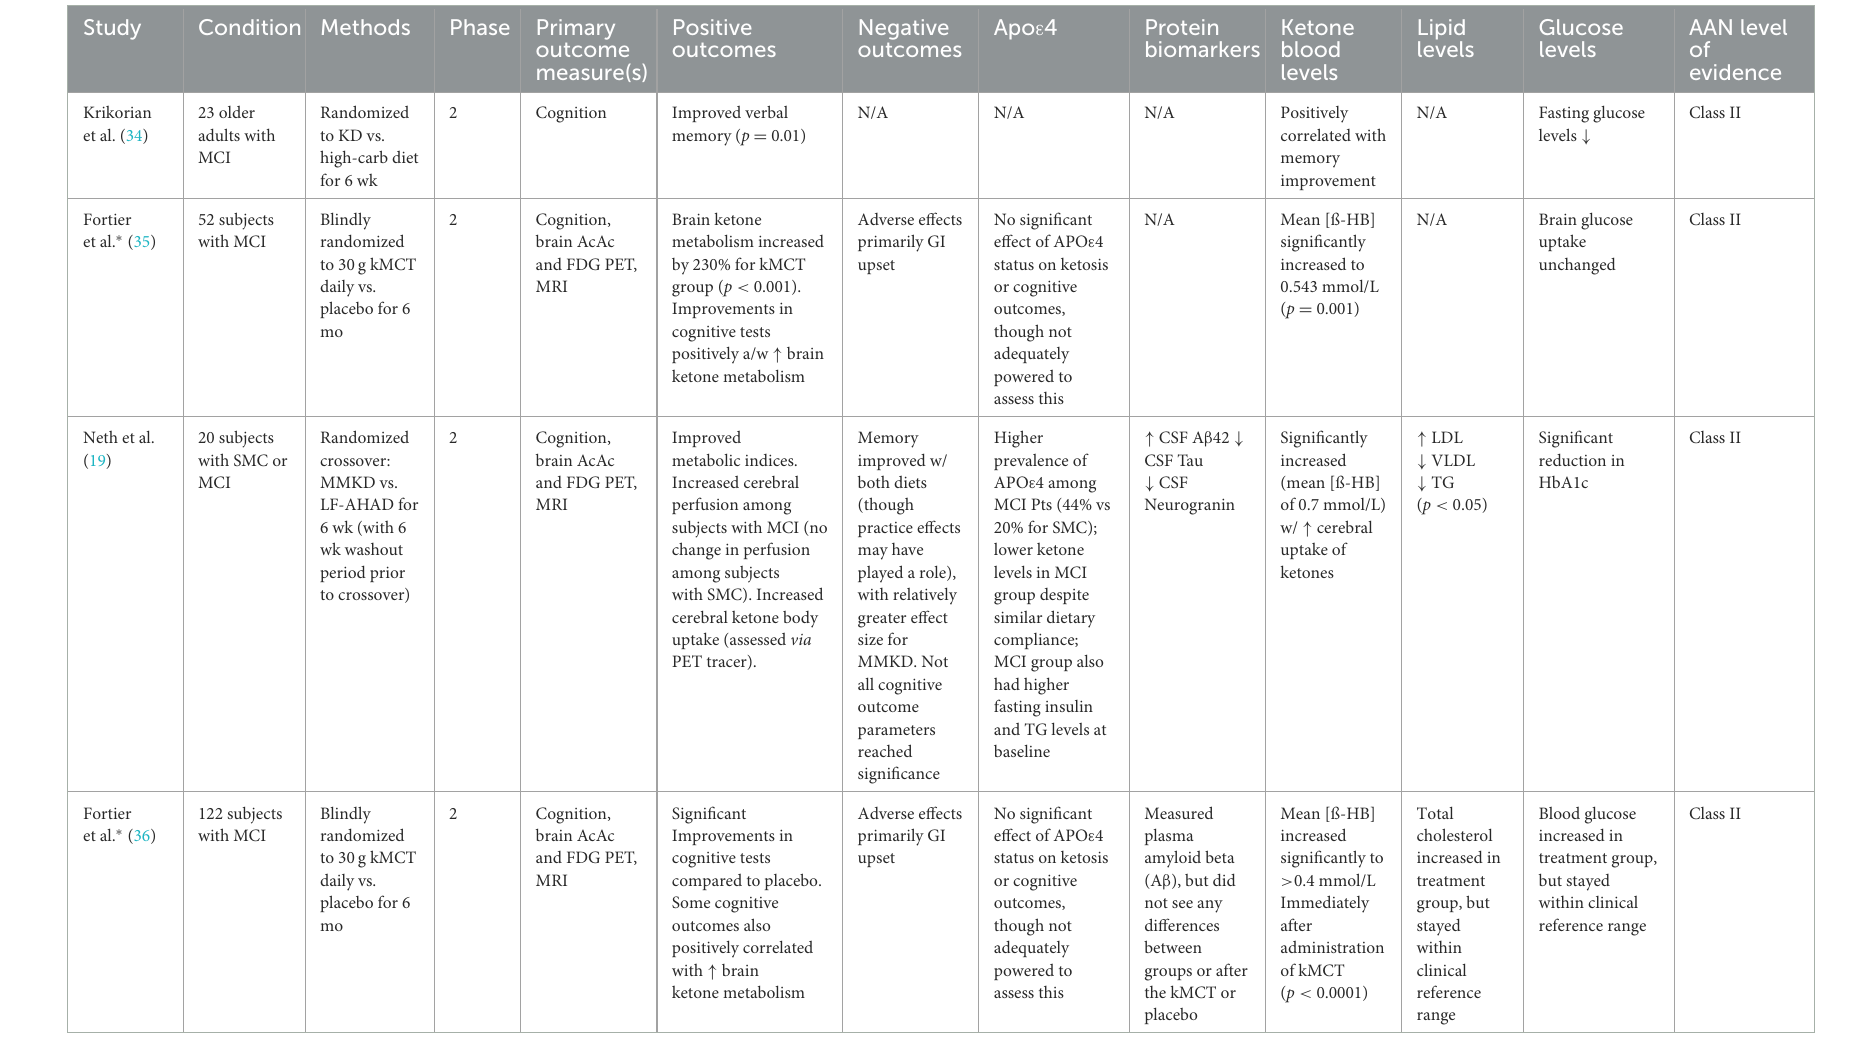
TABLE 1 Literature review of ketogenic interventions for MCI, AD, PD, and aging.